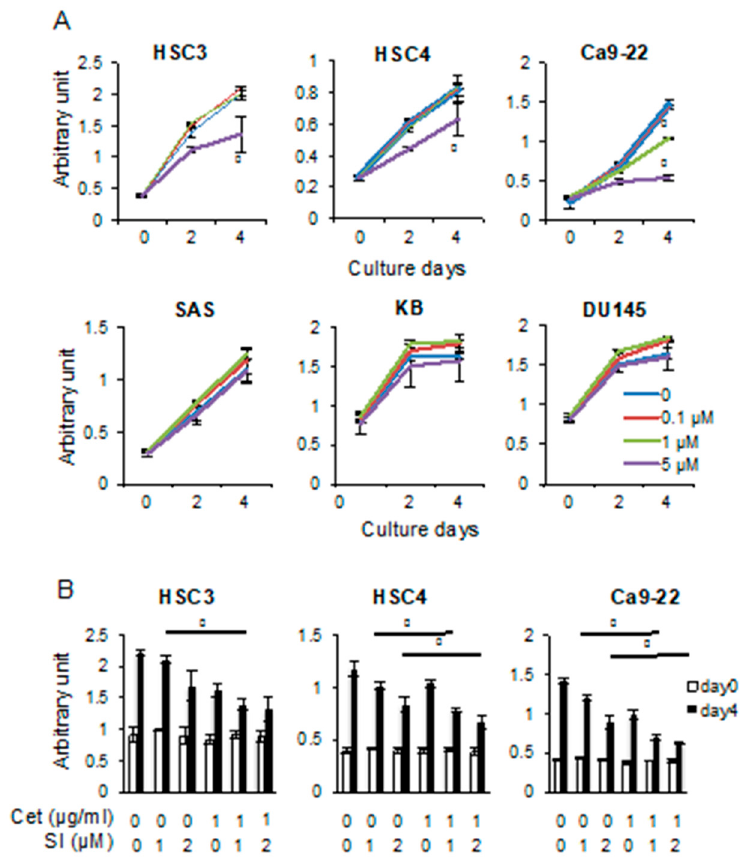
Figure 8. Src inhibitor suppresses cell growth of EIS cell lines more effectively in combination with cetuximab. ( A ) Src inhibitor-1 suppresses the growth of HSC3, HSC4, and Ca9-22 cells in concentration-dependent manner, but does not suppress the growth of SAS, KB, and DU145 cells. Treatment with 0 (blue), 0.1 μ M (red), 1 μ M (green), or 5 μ M (purple) of Src inhibitor-1 was added and MTS assay was performed after 0, 2, and 4 days. ( B ) The combination of Src inhibitor-1 (SI) and cetuximab (cet) is more effective than each alone. After adding cet and SI at each concentration, MTS assay was performed 4 days later and compared with day 0. * Significantly different from control, p < 0.05. Experiments were performed three times independently.